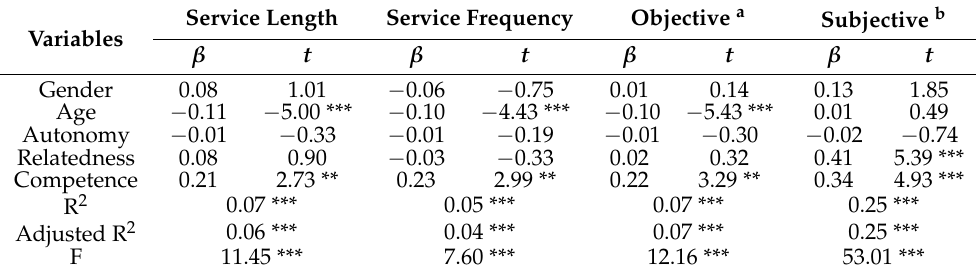
Table 1. Summary of the model estimates for the regression analysis of sustained volunteering.